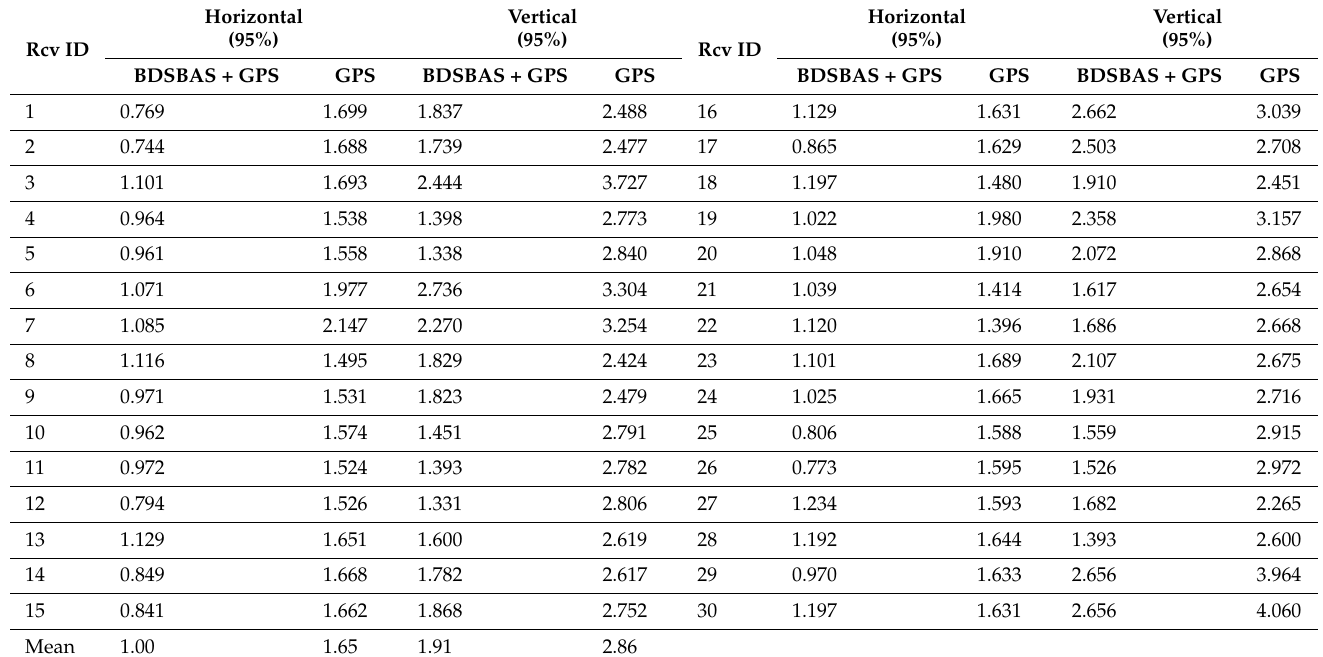
Table 2. The position accuracy statistics of monitoring receivers under the BDSBAS + GPS SF